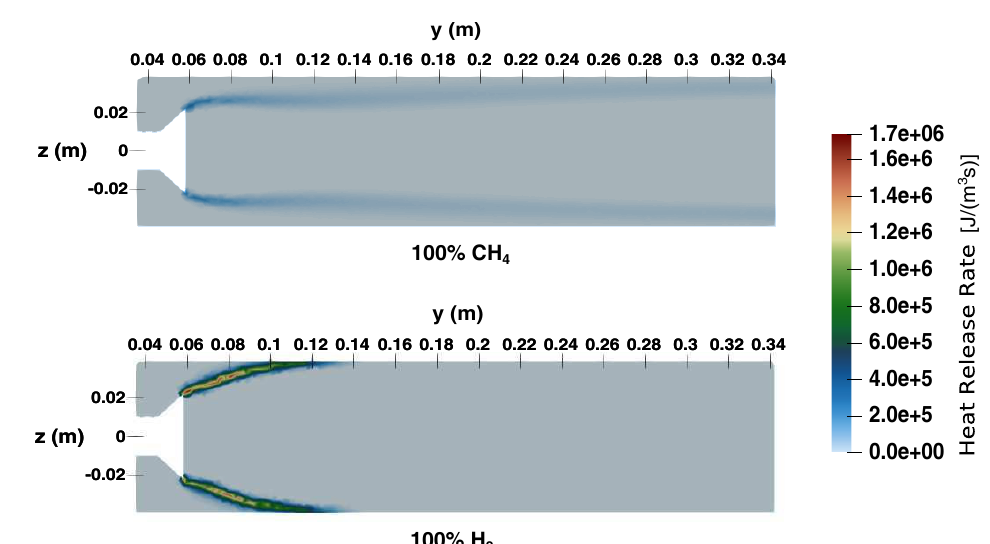
Figure 9. Contours of the heat release rate for the two different mixtures: methane − air and hydrogen − air.